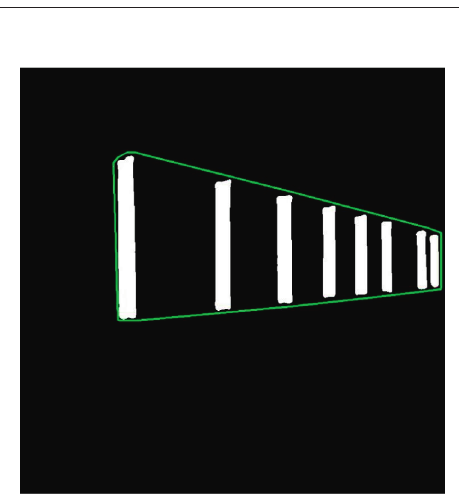
Figure 4: Convex hulls of the anti-glare panel in two